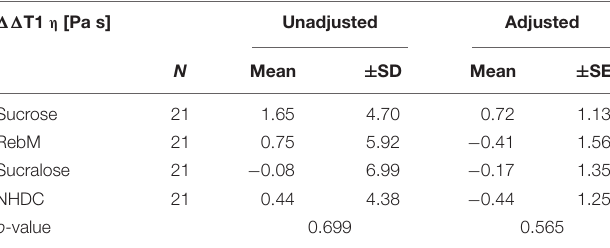
TABLE 4 | Unadjusted values and covariate-adjusted means ( ± SD/SE) of normalized complex viscosity η values ( (cid:49)(cid:49) T1 [Pa s] = [(Tx T0)-(Tx-T0) H2O ]) of saliva samples after stimulation with each test solution analyzed by means of an repeated measures ANCOVA with the basal level of mucin 5B (Muc5B), storage modulus G (cid:48) , phase angle δ , pH, α -amylase activity, threshold, and age of participants as covariates. (cid:49)(cid:49) T1 η [Pa